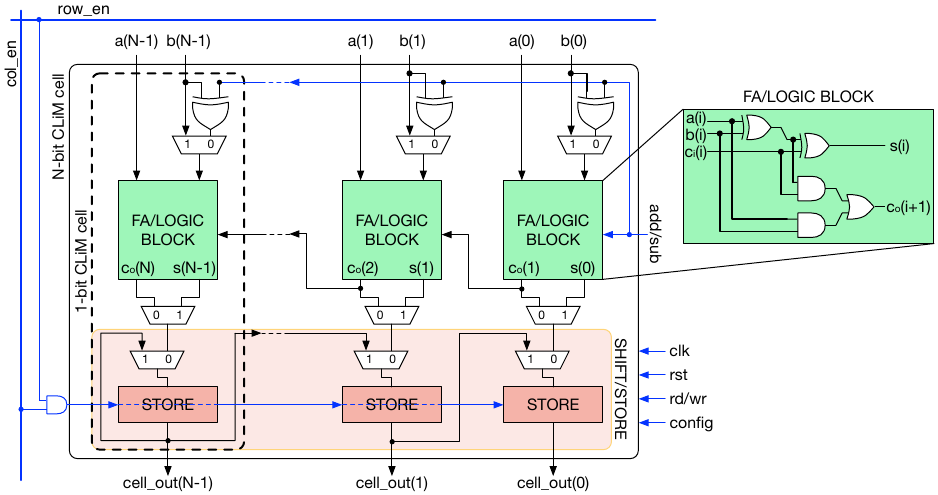
Figure 11. Internal structure of the CLiM cell. Many 1-bit CLiM cells are properly interconnected, exploiting inter-cell connections, to build a more complex N-bit CLiM cell.